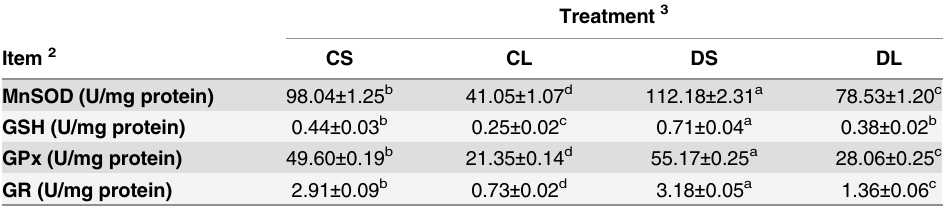
Table 4. Effects of DMG-Na on mitochondrial antioxidant system in LPS-injected mice liver 1 .